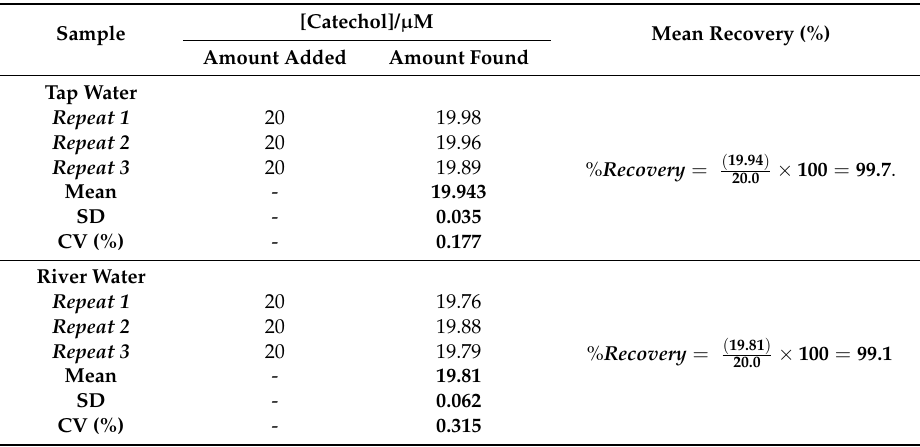
Table 1. Recovery of spiked catechol from natural water